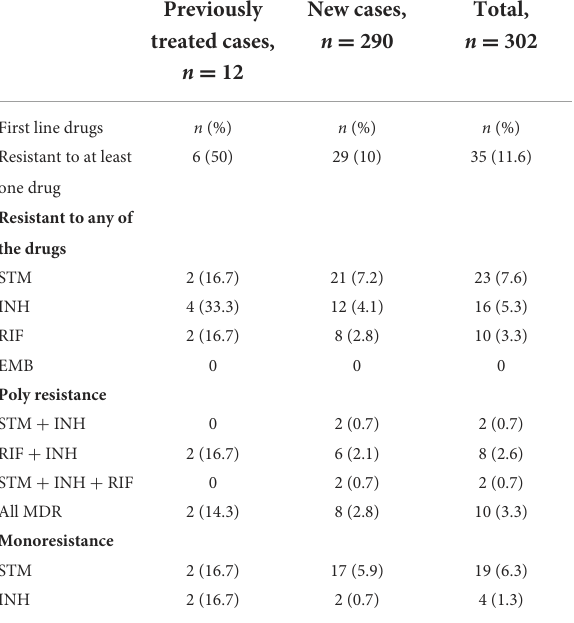
TABLE 1 Drug resistance profiles of new and previously treated patients with tuberculosis (TB) in the Somali Region, Ethiopia ( n =